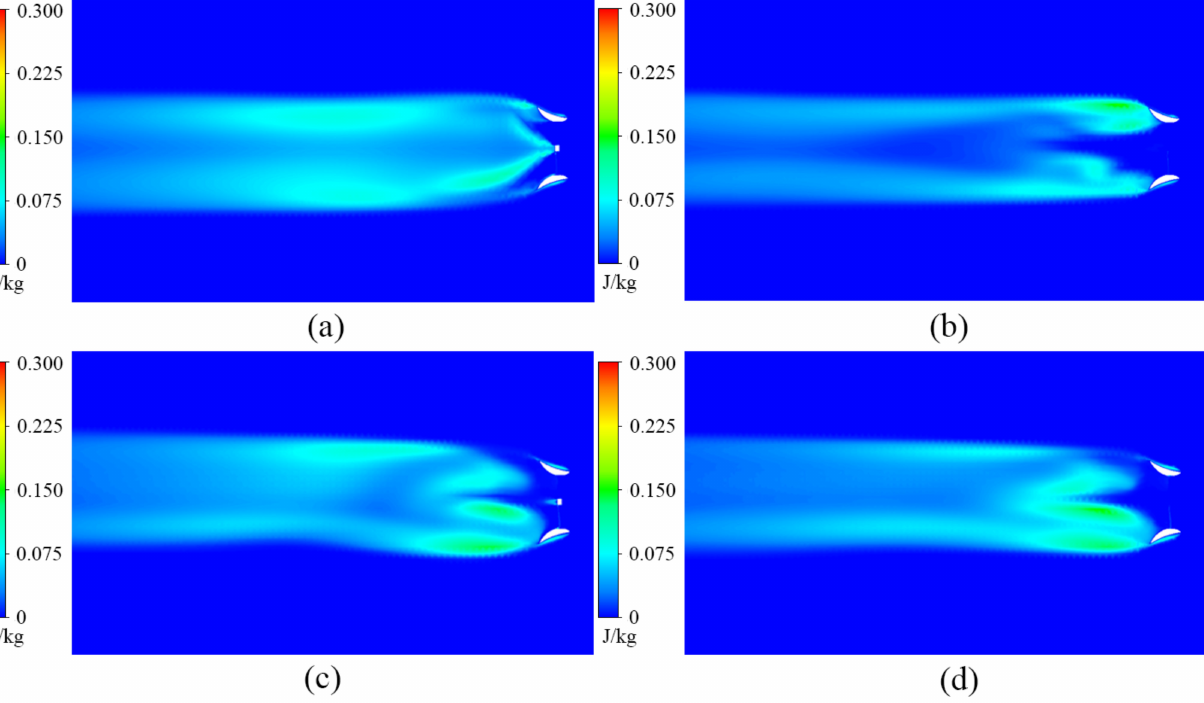
Figure 10. Turbulent kinetic energy distribution comparison between the DT and the SDT: ( a ) DT at TSR = 4.0; ( b ) SDT at TSR = 4.0; ( c ) DT at TSR = 6.0; ( d ) SDT at TSR =